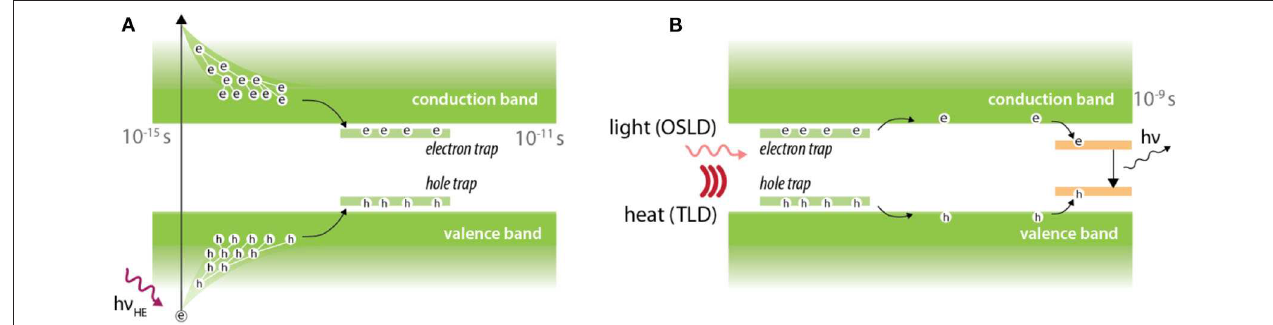
FIGURE 6 | Luminescence in thermally and optically stimulated luminescent detectors. (A) Irradiation leads to promotion of electrons from the valence band to conduction band. Electron and holes are subsequently trapped at trap centers which are introduced by doping impurities into crystals. (B) An external stimulus in the form of heat or light is then provided to facilitate electron-hole recombination at luminescent center, which leads to production of optical